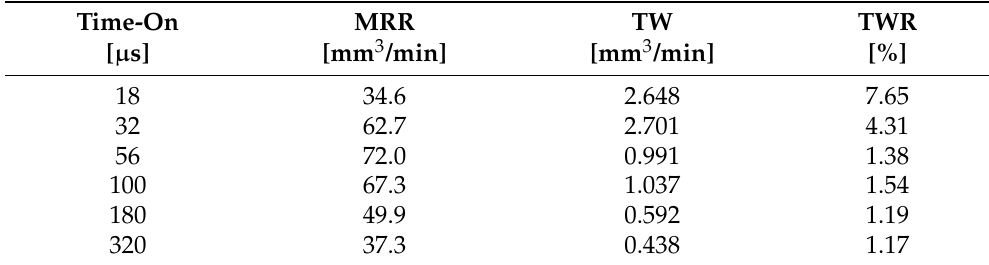
Table 4. Experimental results.